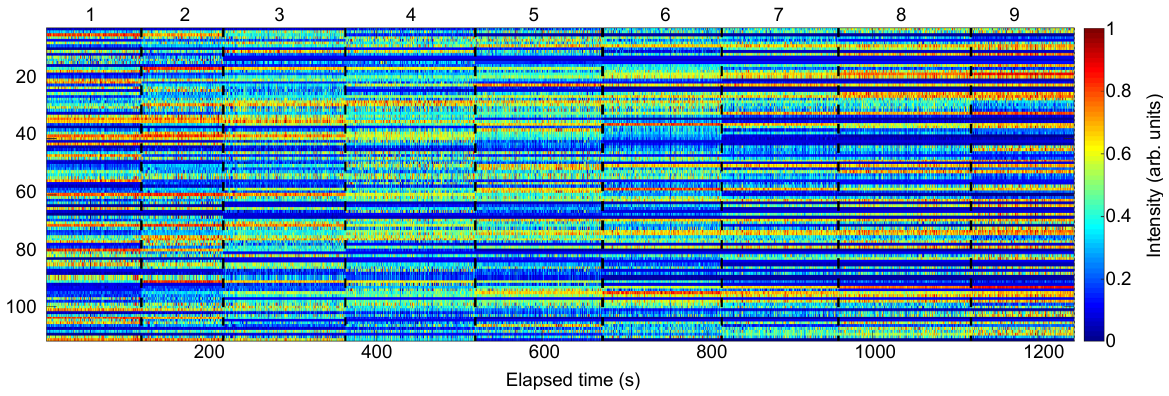
Fig. 4 | Sensor response on the refractive index changes. Following ambient states are represented: water ( 1 ), ethanol solution in water of 0.5% ( 2 ), 1.1% ( 3 ), 1.64% ( 4 ), 2.17% ( 5 ), 2.7% ( 6 ), 3.2% ( 7 ), 3.7% ( 8 ), 4.3% ( 9